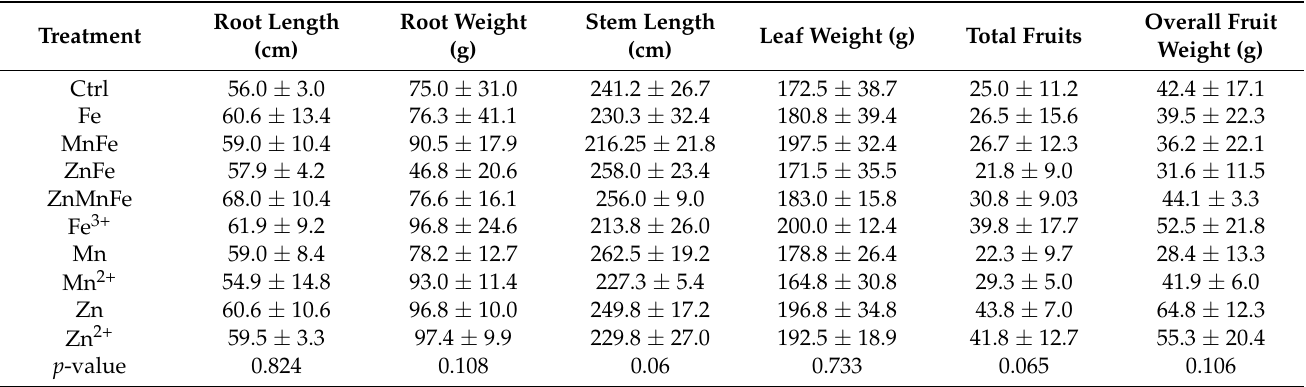
Table 4. Tomato plant physiological parameters and fruit production after exposure to either Fe 3 O